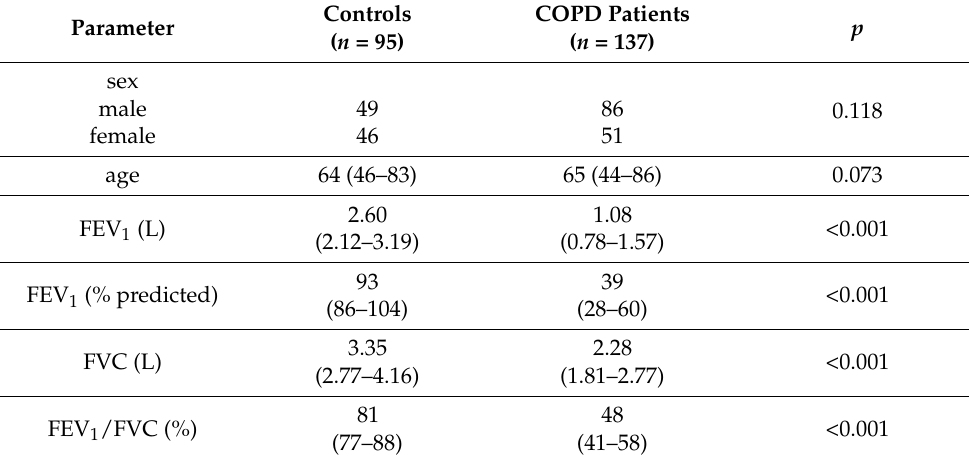
Table 2. Basic characteristics and spirometry parameters of healthy controls and COPD patients included in the study.